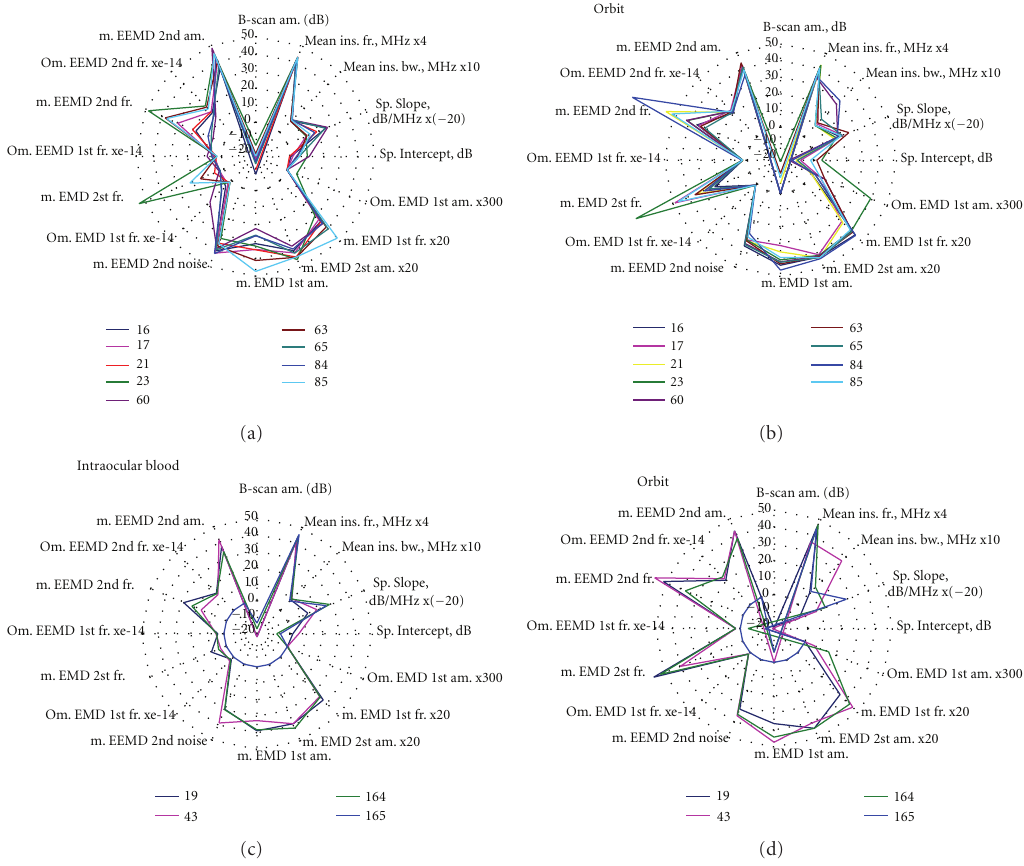
Figure 2: General view of all parameters characterizing: (a) suspicious tissue inside the eye, (b) healthy orbit tissue. Extraocular muscle